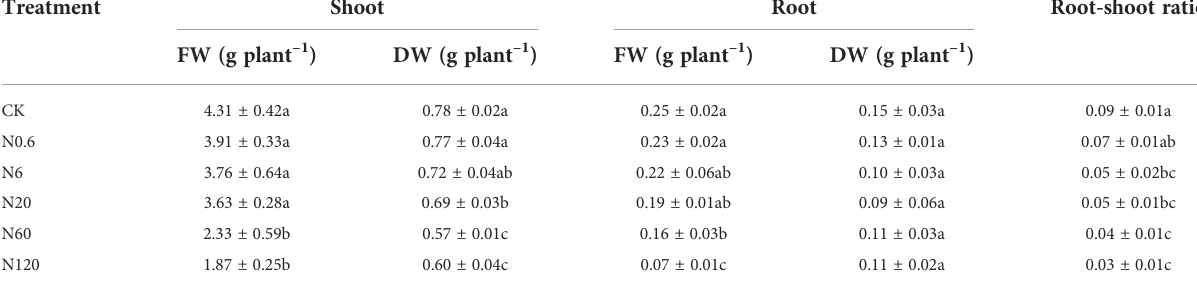
FW, fresh weight; DW, dry weight. Data with the different letters indicate signi fi cant differences between different doses of nicosulfuron drift (n = 6, p < 0.05).